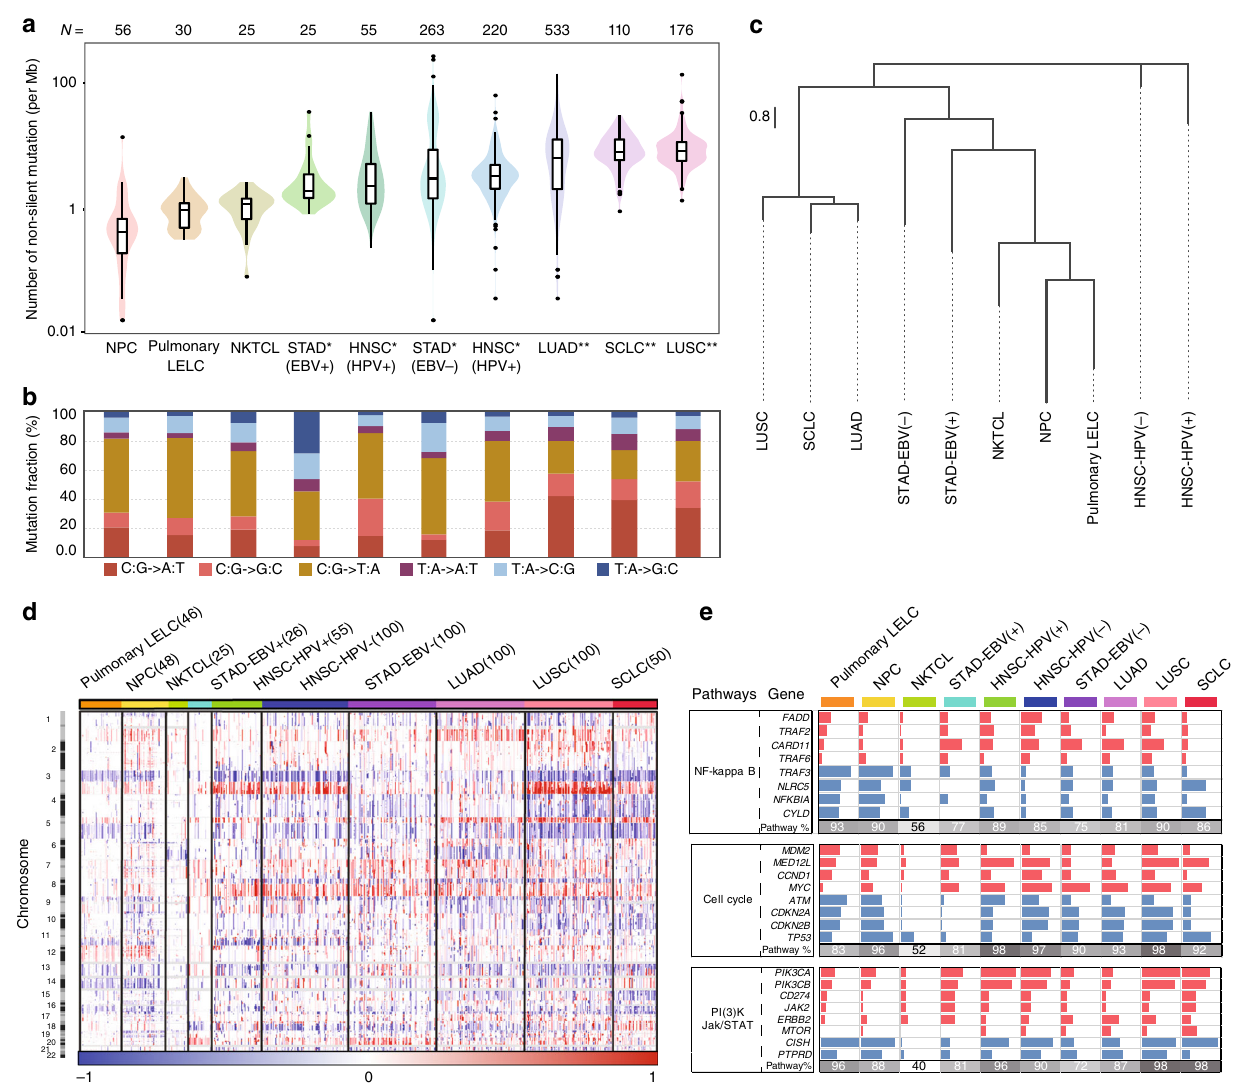
Fig. 5 Comparison between pulmonary LELC and other associated cancer types. a Distribution of non-silent mutation rates of pulmonary LELC and other associated cancer types. The upper numbers indicate the number of samples for each cancer type. Black lines in the boxplot denote median mutation rate for each cancer type and outliers are shown as dots. All the other cancer types are statistically tested by unpaired two-side t -test with pulmonary LELC. * P -value < 0.05 and ** P -value < 0.0001. b Mutation spectrum of six mutation type for each cancer type. c Clustering of 96 subtypes based on six mutation types and nucleotides fl anking the mutated base for each cancer type. d SCNA comparison of pulmonary LELC and other cancer types. e Frequency comparison of genes with copy number ampli fi cation (red) or deletion (blue) for three major oncogenic pathways: NF-kappa B, Cell cycle and Jak/STAT/PI (3)K. Percentages of samples mutated in each cancer type are shown in gray. NPC, nasopharyngeal carcinoma; LELC, lymphoepithelioma-like carcinoma; NKTCL, natural killer/T cell lymphoma; STAD, stomach adenocarcinoma; HNSC, head and neck squamous cell carcinoma; EBV, Epstein-Barr virus; HPV, human papillomavirus; LUAD, lung adenocarcinoma; SCLC, small-cell lung carcinoma; LUSC, lung squamous cell carcinoma; SCNA, somatic copy-number alterations; Mb,